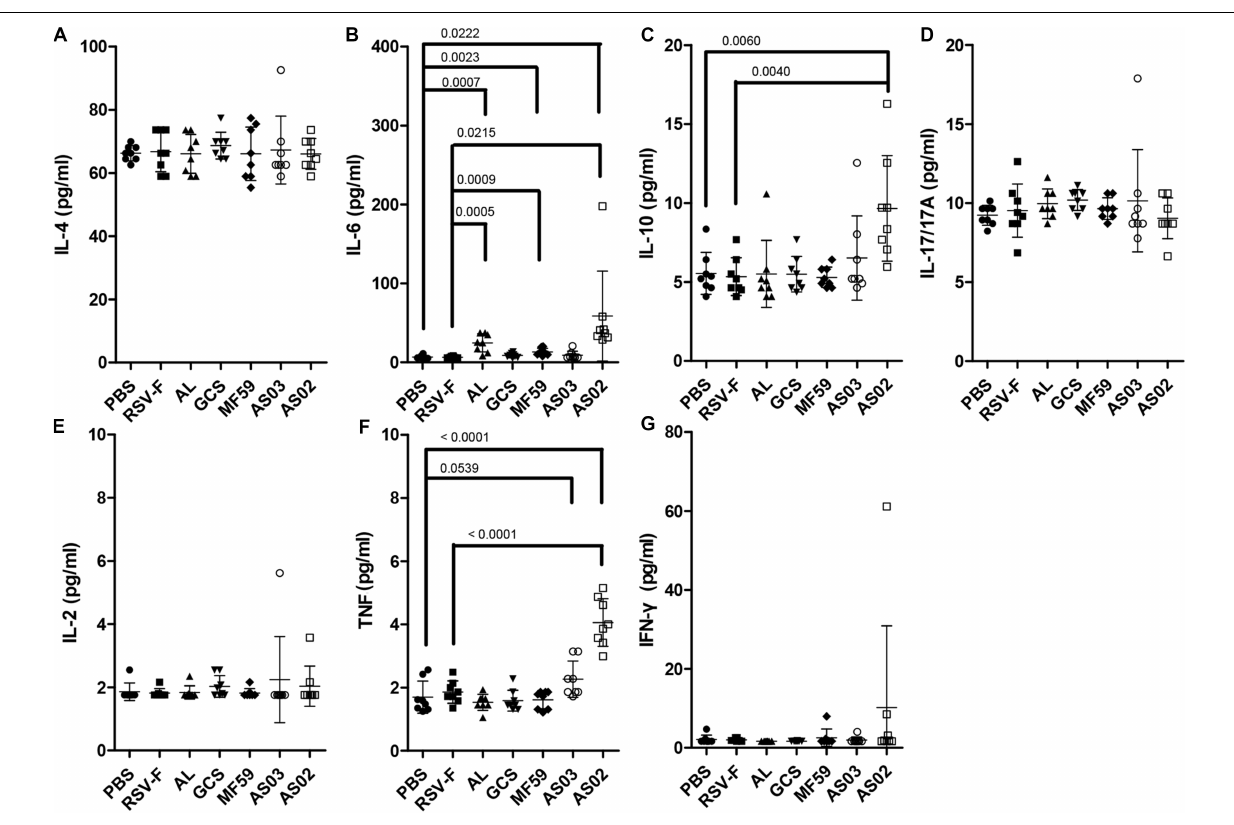
FIGURE 5 | Cytokine levels in the sera of mice intramuscularly immunized with various adjuvanted vaccines and RSV-F alone at weeks 0 and 2. Sera were collected at day 16. IL-4 (A) , IL-6 (B) , IL-10 (C) , IL-17/17A (D) , IL-2 (E) , TNF (F) , and IFN- γ (G) were detected by Luminex. Results are shown as mean ± SD of cytokine levels calculated from all eight mice in each group. Groups that are significantly different from PBS group and RSV-F group are marked with P